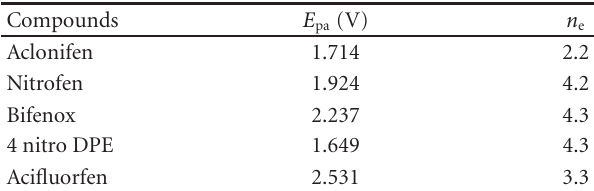
Table 2: Oxidation of nitro diphenyl ether derivatives.